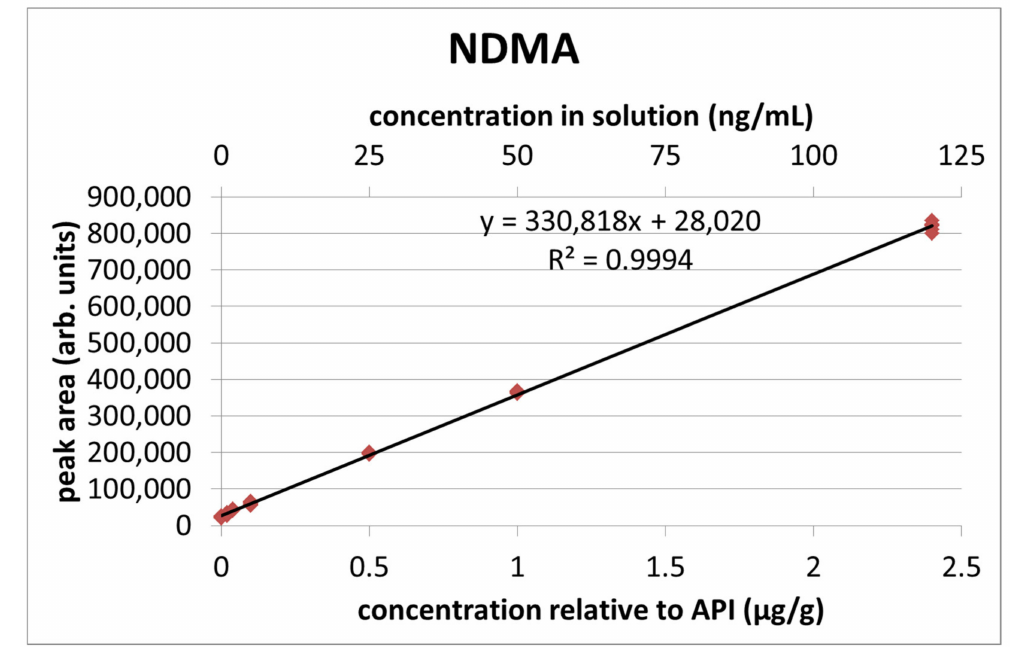
Figure 7. Calibration curve for NDMA. The upper x -scale expresses the concentrations in the solution in ng/mL, and the lower x -scale shows the concentrations in relation to the API, expressed in µ g/g.